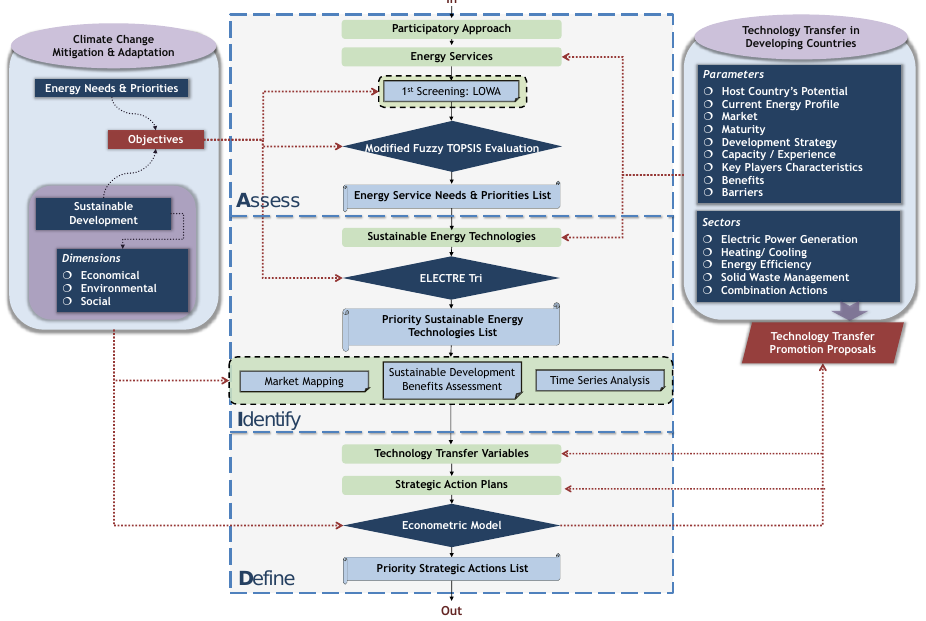
Figure 2. The process of the proposed methodological approach AID.